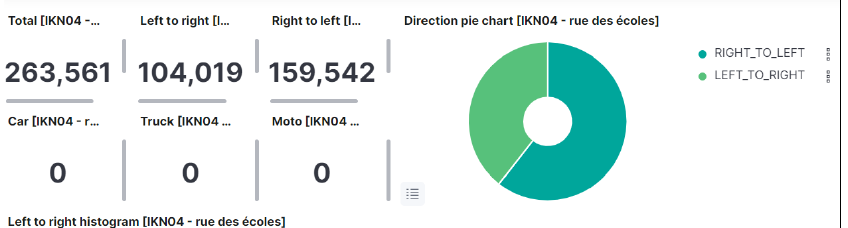
Figure 4. Total number of vehicles from 22 August until 22 September recorded by the sensor IKN04.